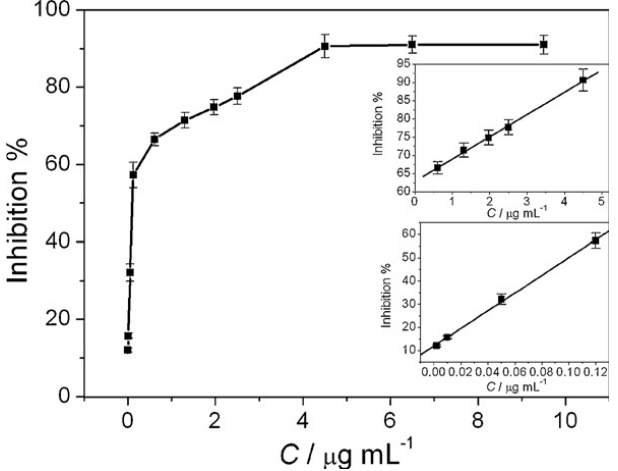
Figure 7. Calibration curve for methyl parathion determination. (Inset) Linear relationships between peak currents and methyl parathion concentrations (reproduced with permission from Gong et al. [20]).